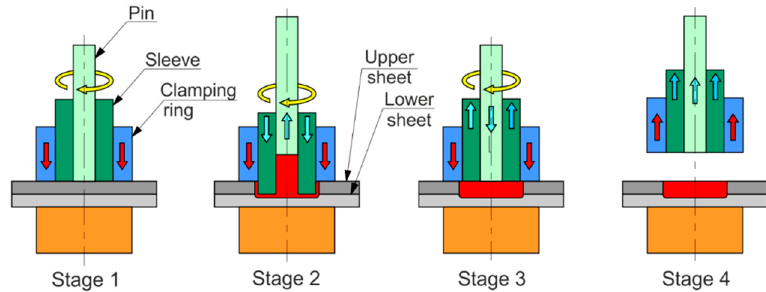
Figure 2. Stages of refill friction stir spot welding.